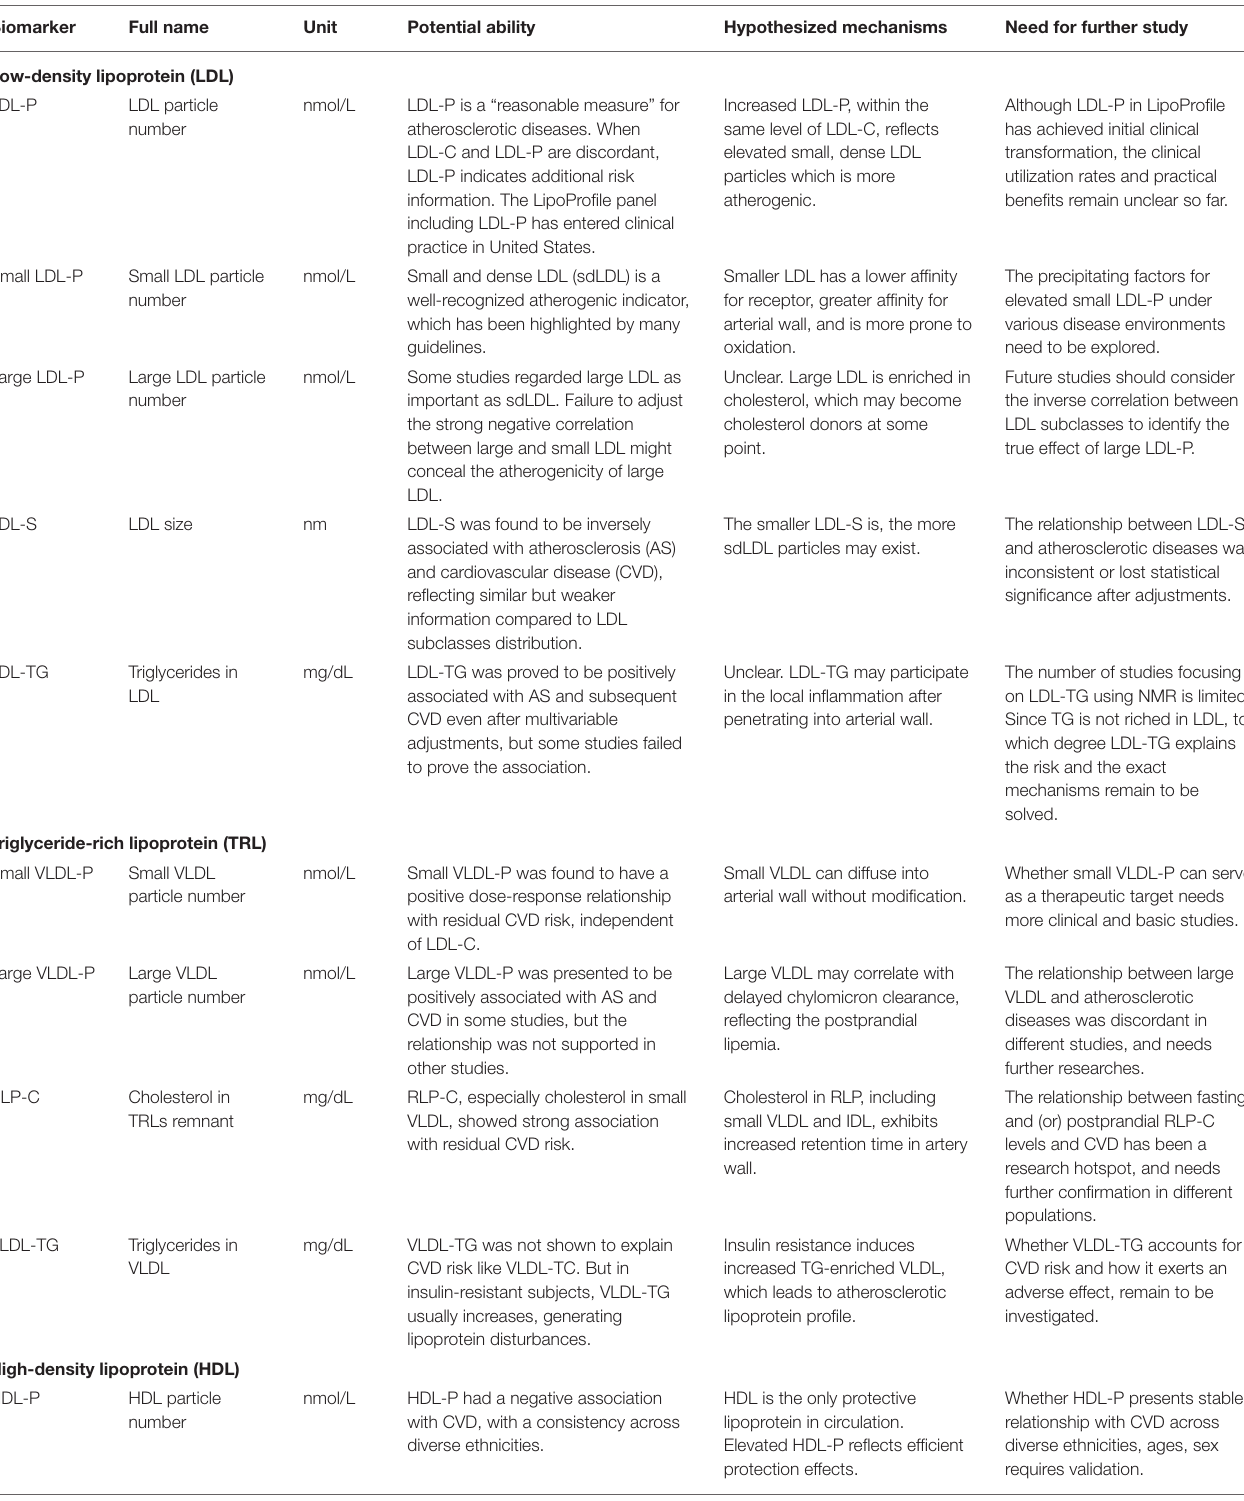
TABLE 1 | Lipoprotein biomarkers of atherosclerotic diseases identified in epidemiological studies using quantitative NMR metabolomics.